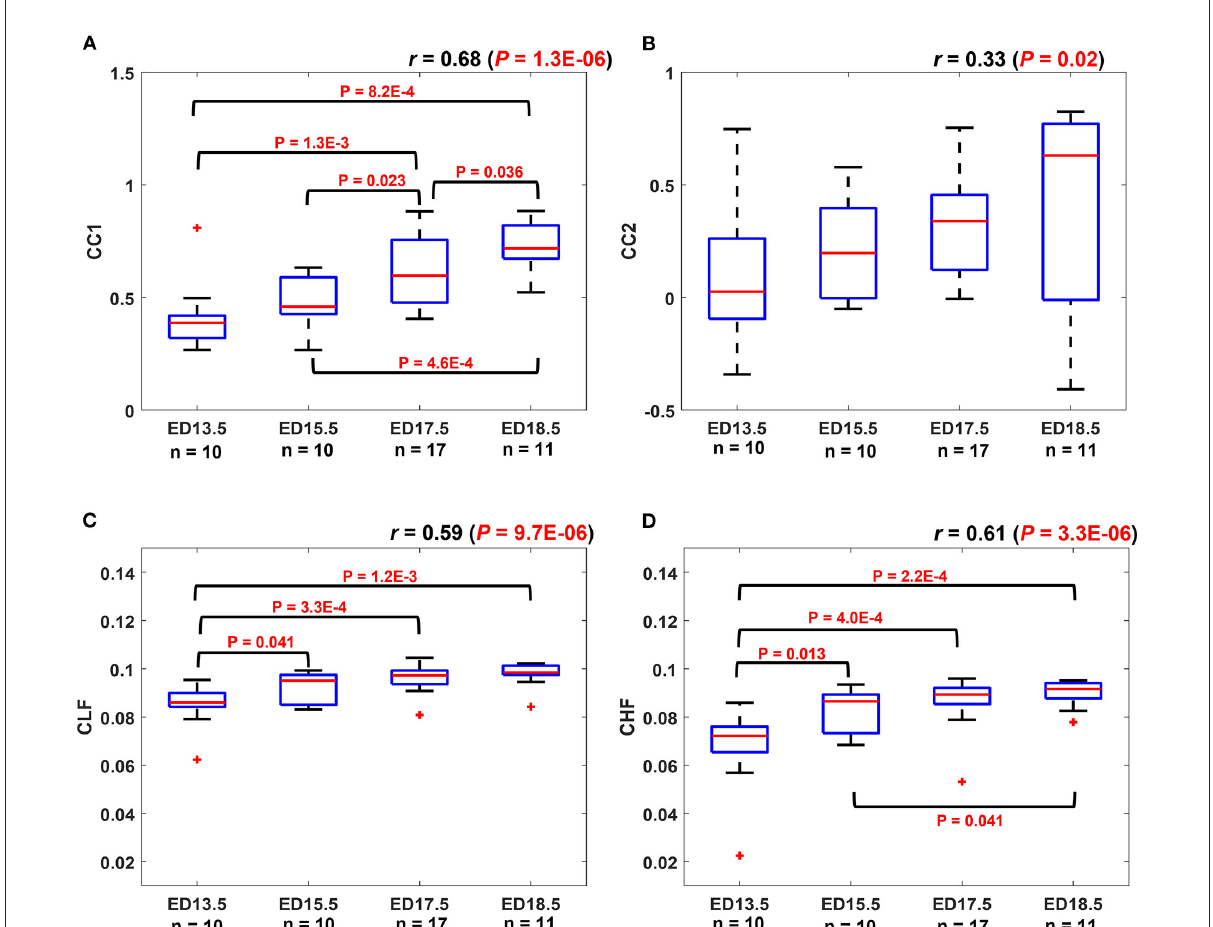
FIGURE4 Similarity coefficients at different developmental stages. The similarity between maternal and fetal RR interval (RRI) was quantified by using four coefficients: (A) CC1, (B) CC2, (C) coherence low frequency (CLF), and (D) coherence high frequency (CHF). The value of correlation between the coefficient and embryonic days (EDs) is indicated as r above the